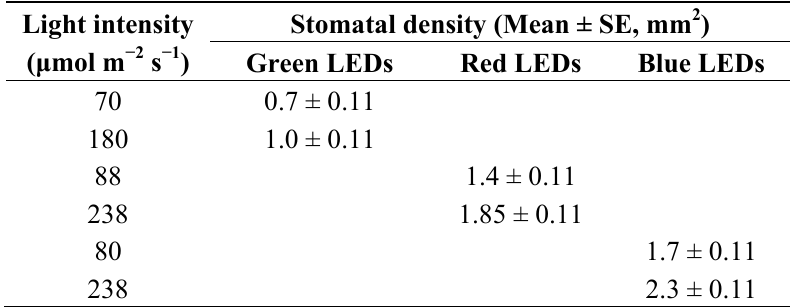
Table 1. Stomatal densities at respective different LEDs with different light